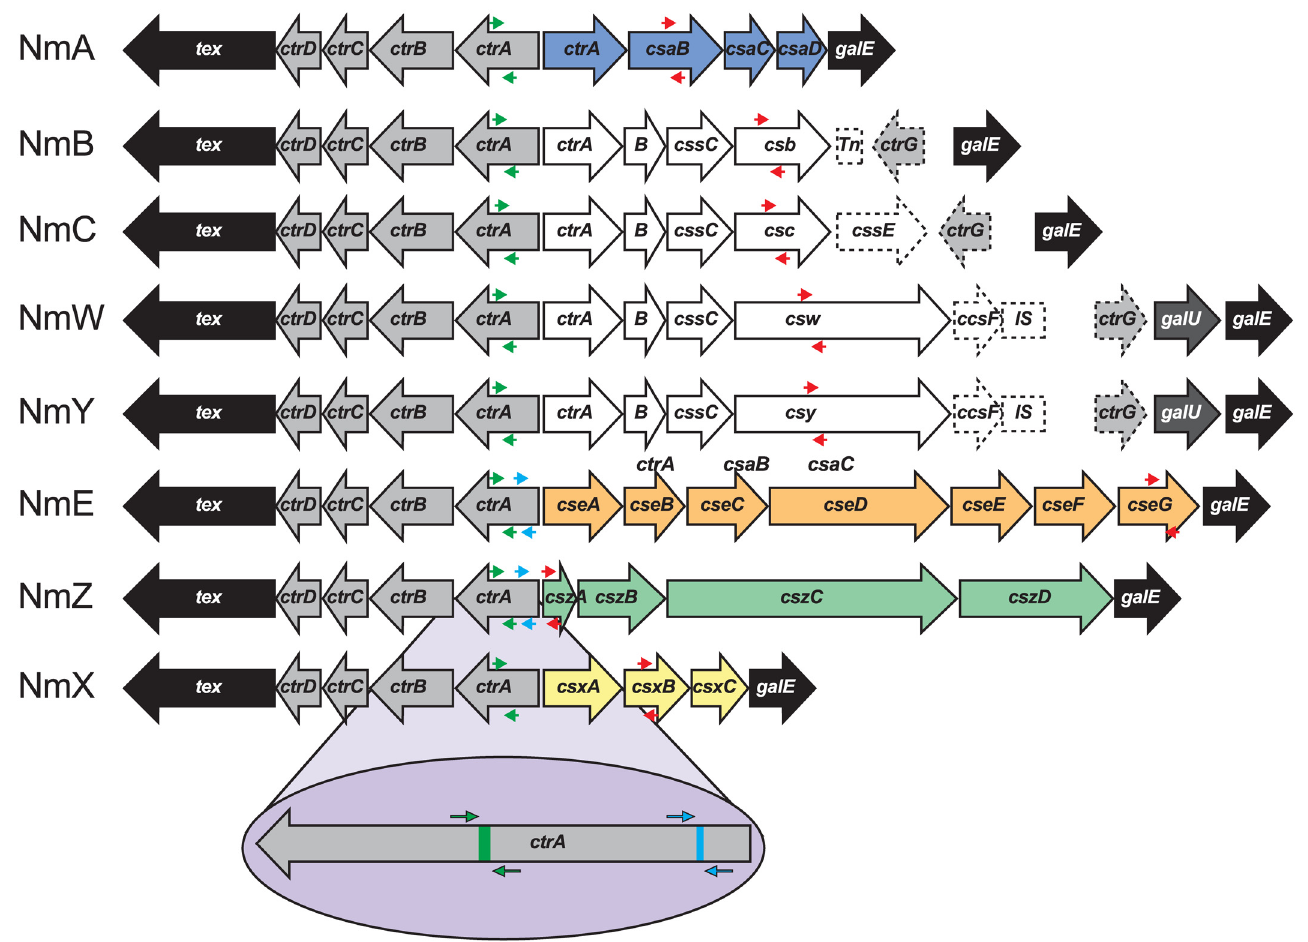
Fig 1. Location of serogroup-specific PCR amplicons in capsular biosynthesis genes of N . meningitidis serogroups A, B, C, W, Y, E, Z, and X. Genes ctrA-D encode capsule transport proteins conserved among all eight serogroups. Genes cssA-C are responsible for the sialic acid capsular component of serogroups B, C, W, and Y, while csb-c-w-y encode the sialyltransferases that produce the serogroup-specific linkages of sialic acid with glucose or galactose. Capsule biosynthesis genes csaA-D , csxA-C , cseA-G , and cszA-D , are unique to A, X, E, and Z serogroups, respectively. Polysaccharide transport and biosynthesis genes are flanked by tex and galE (black arrows). Genes at the distal end of the biosynthetic clusters in serogroups B, C, W, and Y are shown as dotted arrows, and annotated as described previously [35]. The green arrows indicate the location of the ctrA primers used to detect all eight serogroups. Light blue arrows represent the initial primers designed to identify NmE and NmZ, based on sequence at the 5 ’ end of the ctrA gene. The red arrows represent the position of the final primers designed for the eight serogroup-specific assays. The blow-up at the bottom illustrates the position of ctrA primers and probes in greater detail.